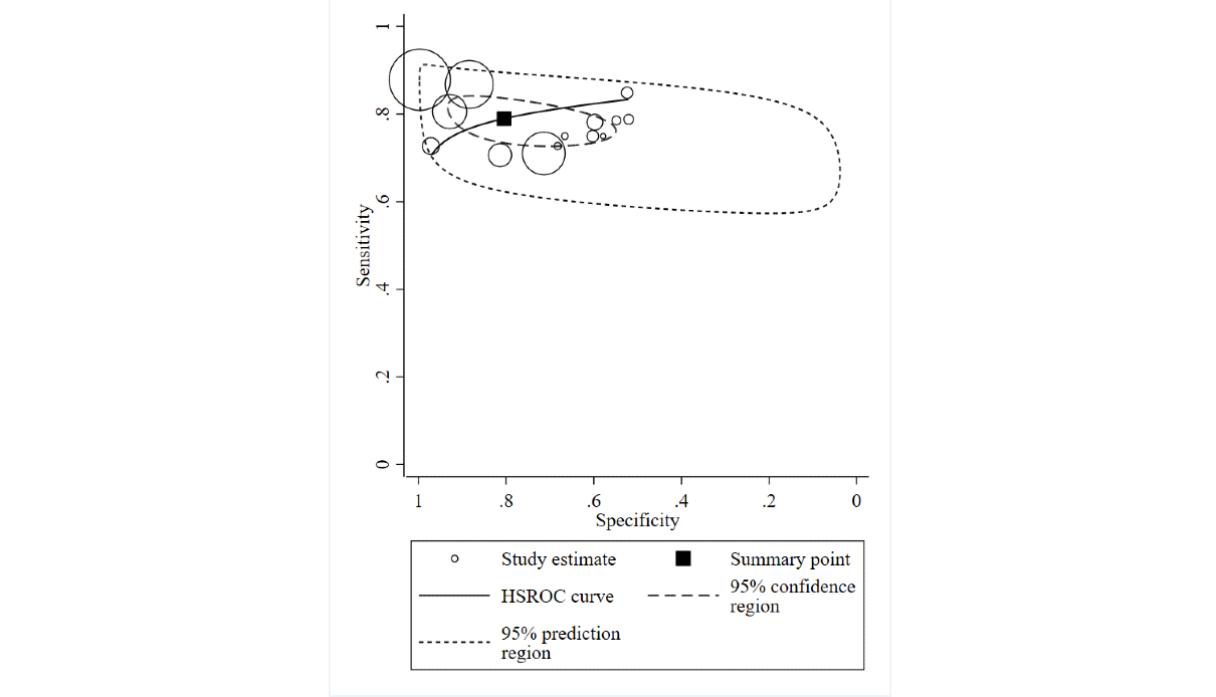
Figure 1. Hierarchical summary receiver-operating characteristic (HSROC) curve for detection of hypoglycemia using machine learning algorithms. Circles indicate study-specific sensitivity and specificity for each of the 14 included studies. The size of each circle is proportional to study sample size. The pooled point estimates of sensitivity and specificity are plotted in a filled